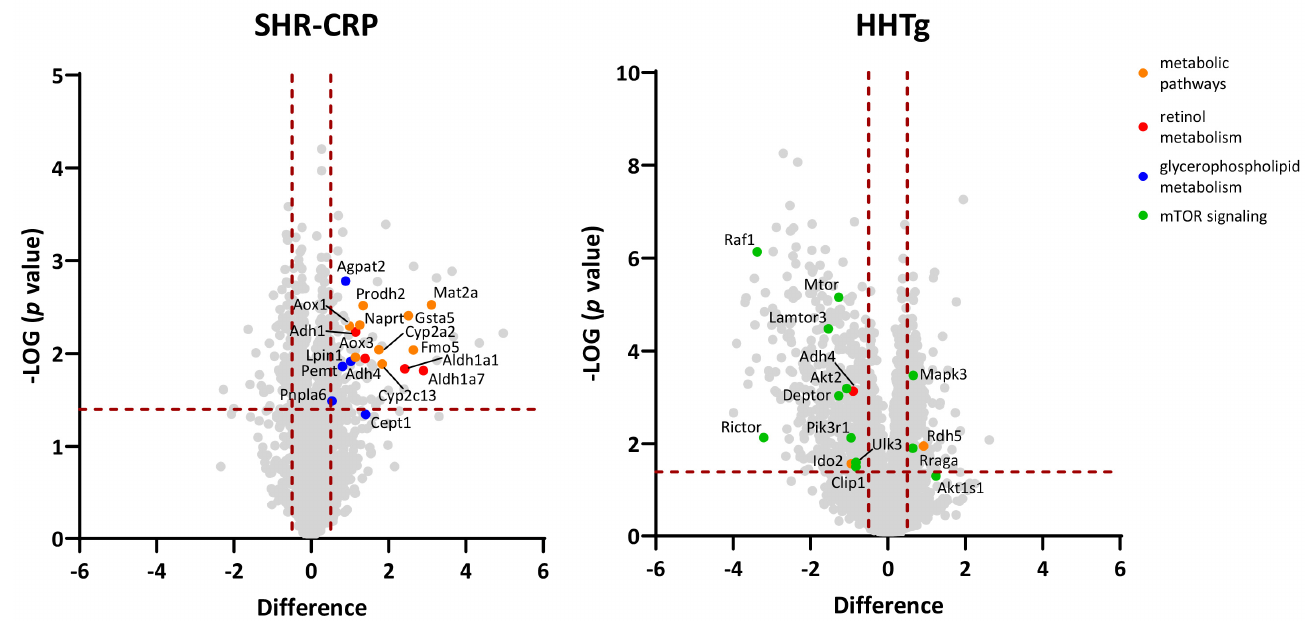
Figure 4. Proteomic analysis of liver samples. Label-free quantification—mass spectrometry analysis (LFQ-MS) of liver tissue from SHR-CRP and HHTg rats. Volcano plots depicting differential content of proteins upon treatment with beetroot juice are shown. The X -axis is the Log2 of linear fold change (beetroot–controls) and the Y -axis is the negative Log10 of the Benjamini–Hochberg corrected t-test p value. Vertical red dashed lines denote the cut-off for a linear fold change of 0.5 in either direction; horizontal red dashed line denotes a cut-off of 0.05 for p value. Proteins which belong to significantly changed KEGG pathways (see Tables 4 and 5) are highlighted.